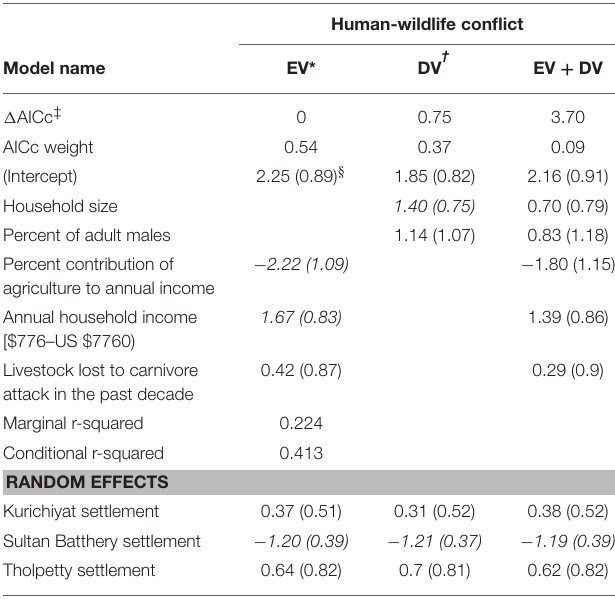
TABLE 3 | Top-ranked models (cumulative weight > 0.95) and beta estimates of fixed, and random effects for predicting the likelihood that households want to relocate to minimize losses from human-wildlife conflict, at Wayanad Wildlife Sanctuary.